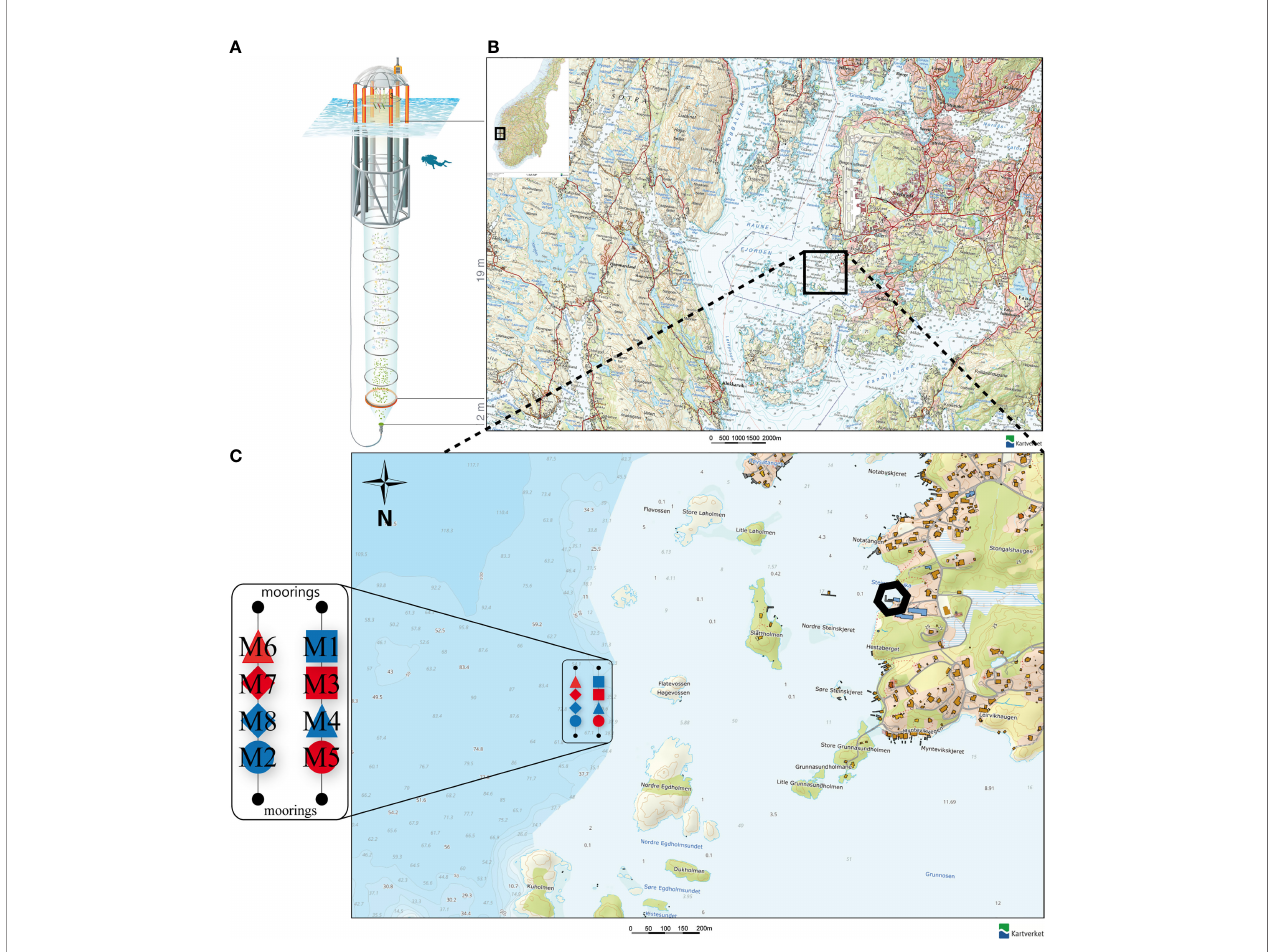
FIGURE 1 | (A) Kiel Off-Shore Mesocosm for Ocean Simulations (KOSMOS), a pelagic mesocosm system. Blue corrugated area represents water surface. Diver for scale. Illustration of the KOSMOS unit by Rita Erven (GEOMAR), reprinted with permission from the AGU (B) Location of the Raunefjorden at the coast of Norway. Black square indicates deployment area of the mesocosms. (C) Position, order and symbols of the KOSMOS units M1 – M8 in their deployment area near the Espegrend Marine Research Field Station, Bergen (black hexagon). Red fi lling of the respective mesocosm symbol indicates CO 2 manipulation and blue fi lling the control group. Symbols and denomination of the mesocosms will be used uniformly throughout the manuscript. Small numbers in the map indicate the water depth in meter. (B , C) modi fi ed after: The Norwegian Mapping Authority (Kartverket, accessed February 15 th 2021,